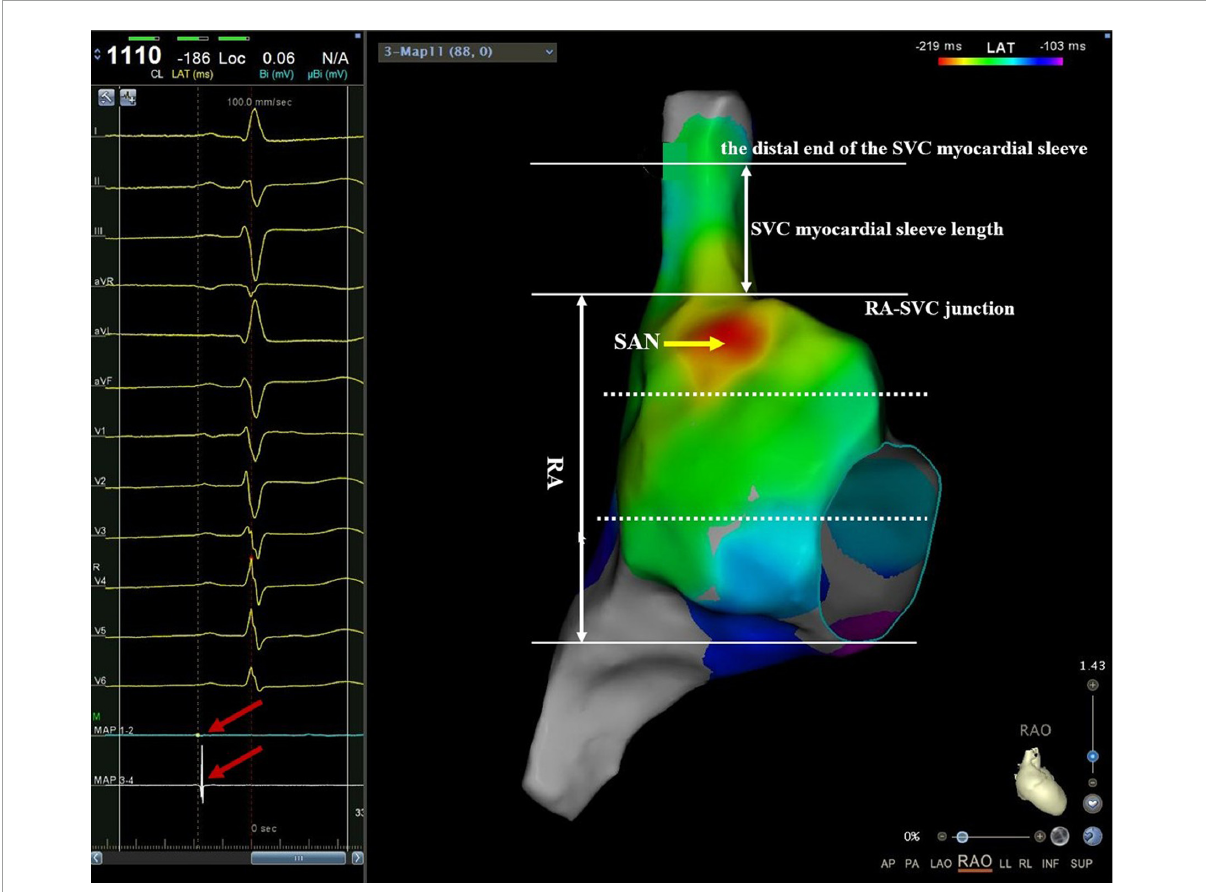
FIGURE1 An example of mapping catheter-guided SVC activation mapping. Manipulating the mapping catheter along with the RA from the caudal to the cranial direction to reconstruct the 3D activation map of RA and SVC. At the junction of RA-SVC, both the proximal 1–2 electrode and the distal 3–4 electrode could record the SVC potential. Then, the catheter was slowly moved toward the cranial direction with 3–5 g pressure. When the SVC potential of the proximal electrode of the catheter just disappeared, and at the same time, the SVC potential of the distal electrode still existed (red arrow on the left plan), the plane of the proximal electrode of the catheter was indicated the end of SVC musculature sleeve. The myocardial sleeve length of SVC was defined as the vertical distance from the junction of RA-SVC to the distal end of the myocardial sleeve. The RA was divided into three equal parts in the right anterior oblique position, namely, high, middle, and low RA. Note that the red region indicates the location of the SAN. RA, right atrium; SVC, superior vena cava.